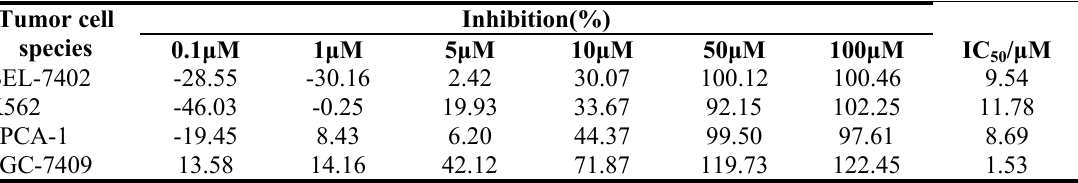
Table 4. Evaluation of the cytotoxic activity (IC tumor cell